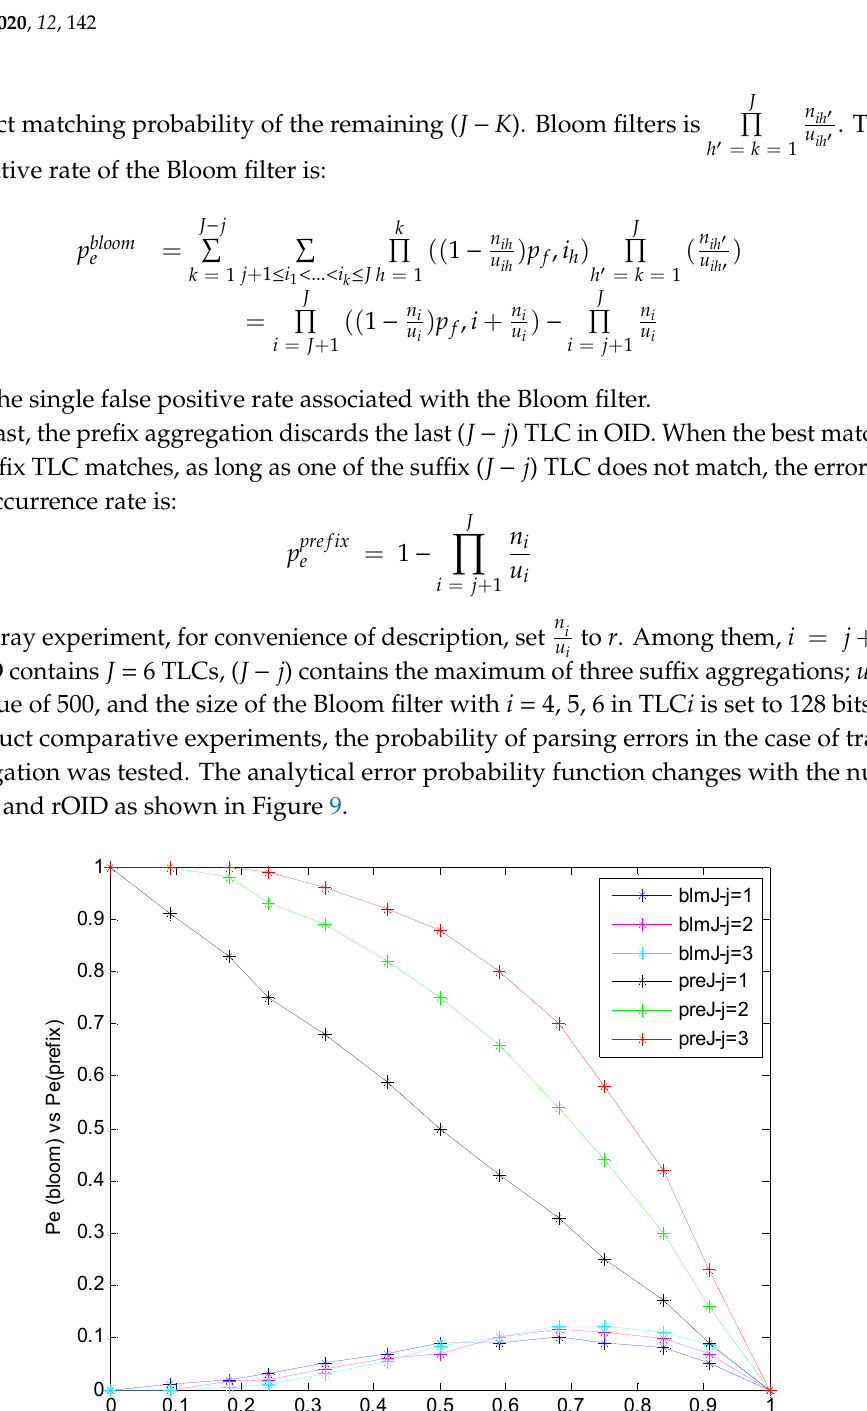
Figure 10. Comparison of query time of different layers in the mixed naming method.